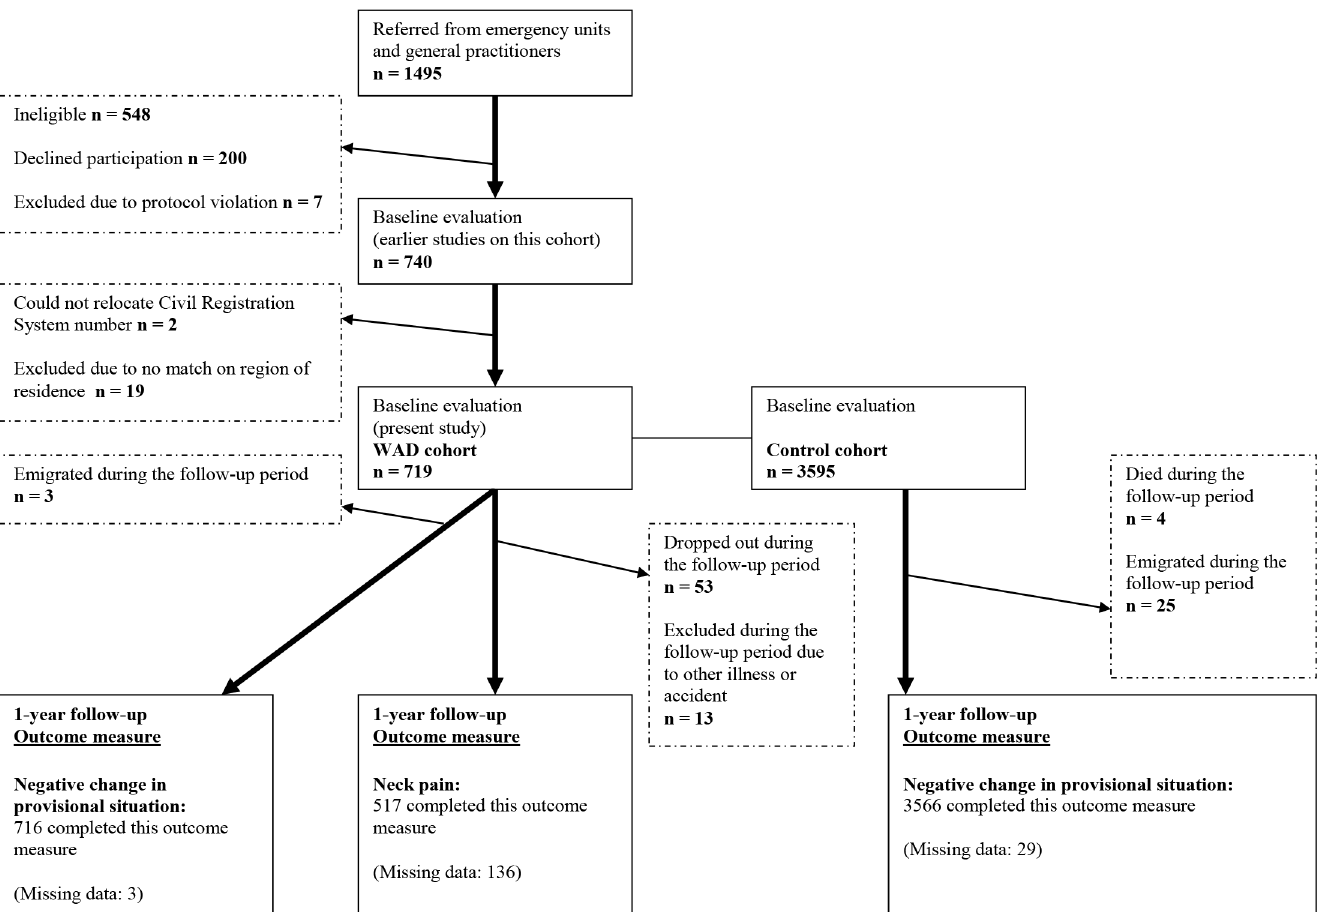
Fig 2. Flow chart of inclusion, exclusion and outcome of whiplash and control